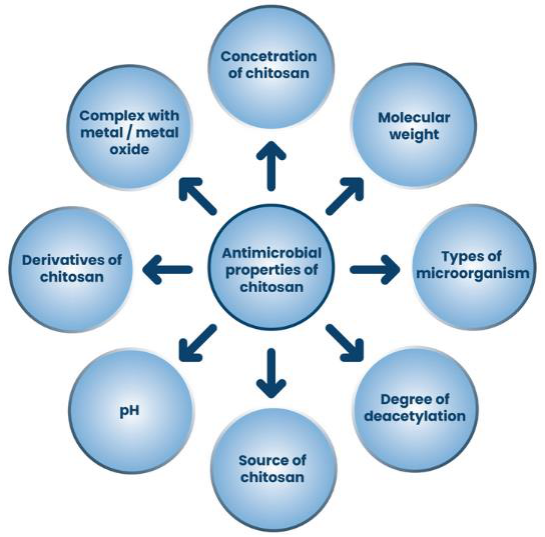
Figure 5. Factors influencing antimicrobial properties of chitosan.